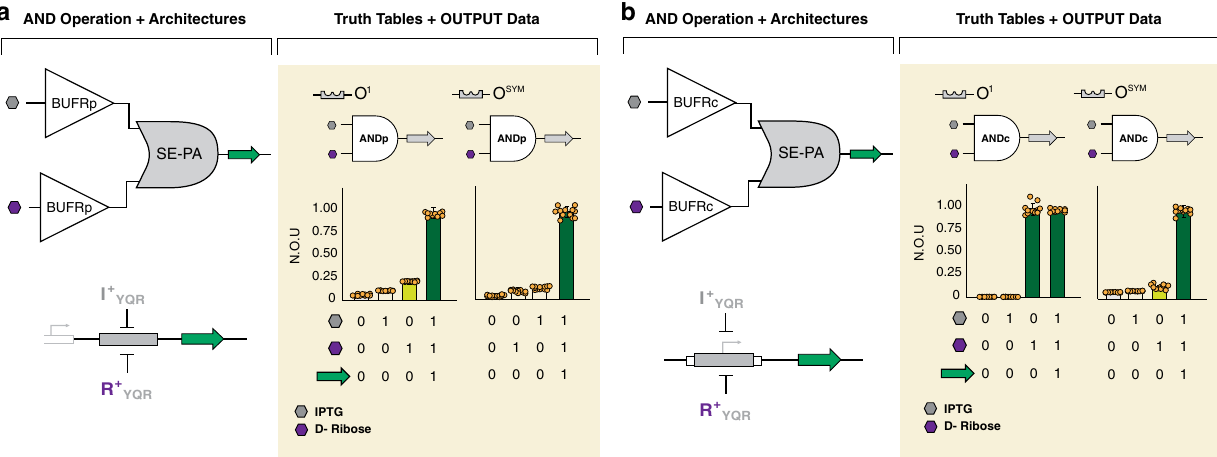
Fig. 6 Transcriptional AND gates. AND gates may be constructed using combinations of BUFFER operations, here, highlighting the series-parallel (SE-PA) architecture. In plots, vertical-bars display normalized output units (N.O.U.), the standardized mean (de fi ning the measure of centre) fl uorescence intensity as a fraction of the maximum observed for that operation ±1 S.D., and truth tables are shown, below, corresponding to bars, above, for different ligand conditions. Results shown are from n = 12 independent biological replicates with similar results, dots shown for each replicate. a ANDp gates were constructed from two BUFRp operations. I + YQR and R + YQR both regulated GFP via a proximal O 1 (left) or O SYM ( right ) operator. Only in the presence of both ligands, IPTG and D-ribose, was repression from both TFs relieved, allowing transcription. b ANDc gates were constructed from two BUFRc operations. Here, I + YQR and R + YQR both regulated GFP via a core O 1 (left) or O SYM (right) operator. Results with the O 1 operator did not show AND behavior, while O SYM allowed realization of the AND operation. See Supplementary Fig 10 for realization of the AND operation using an O 1(core)